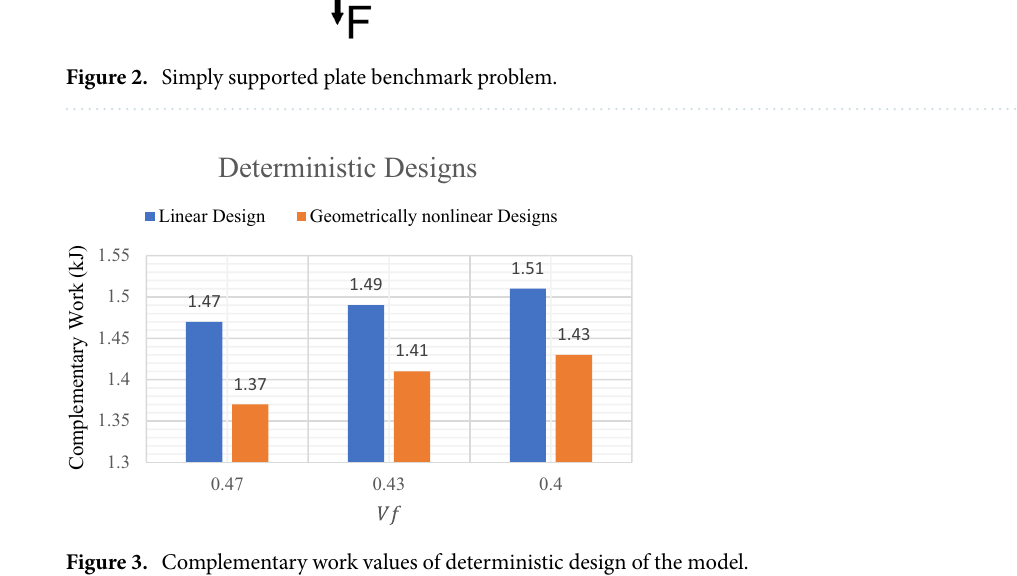
Figure 3. Complementary work values of deterministic design of the